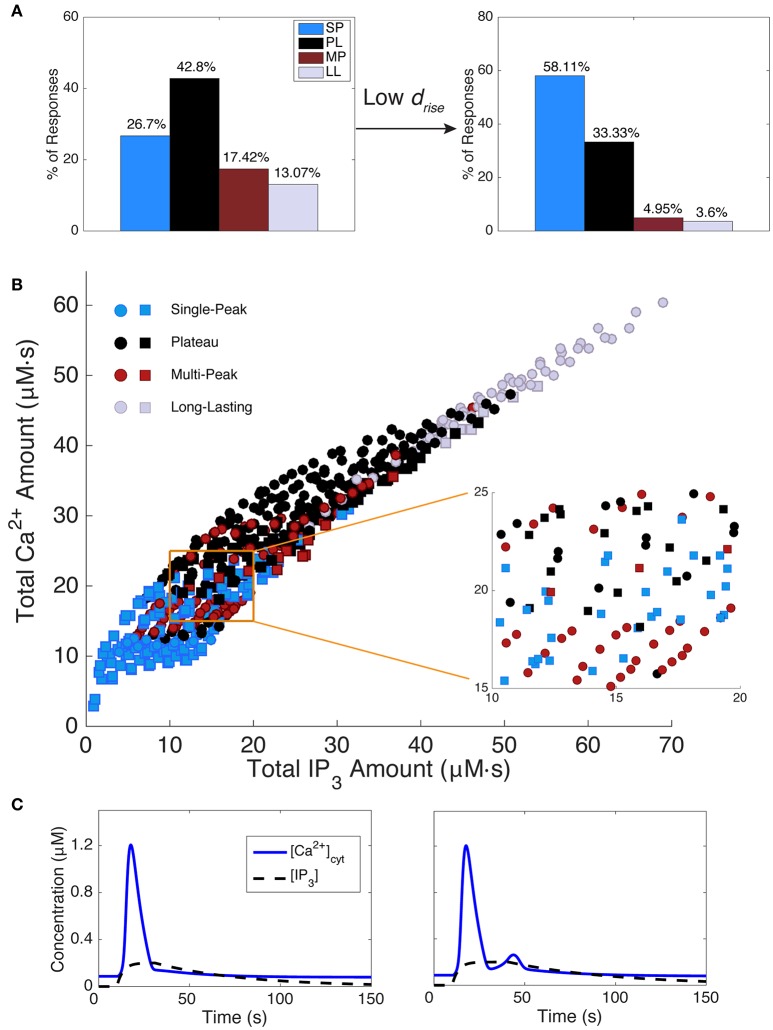
Effect of IP3 kinetics on Ca2+ responses. (A) The left histogram shows the distribution of model response types while scanning IP3 kinetics over the full parameter range from Table 1. The right histogram plots the response type distribution for shorter IP3 rise durations (drise < 22 s). Shorter IP3 rise durations tend to decrease the occurrence of mostly MP and LL responses, with SP being the major response type, while longer IP3 rise durations decrease the percentage of SP responses, but increase other response types. (B) The total IP3 amount correlates with the total Ca2+ amount. However, in most regimes, within a small range of IP3 (and Ca2+) amounts, a mixture of Ca2+ response types are generated. An example of such a regime is shown in the zoomed section. Squares indicate responses generated with drise < 22 s (corresponding to data set in the right histogram in (A) and circles indicate responses generated with all other drise values from Table 1. (C) Two example Ca2+ responses are shown with their underlying IP3 dynamics. As seen, a small change in IP3 kinetics is sufficient to change the Ca2+ response type from SP to MP, while the total IP3 amount remains roughly the same (15.28 and 15.17 μM, respectively; Ca2+ amounts are 13.86 and 15.56 μM, respectively). IP3 parameters (A, drise, rrise, ddec): 0.2, 21, 0.3, 220 (SP), 0.2, 31, 0.3, 179 (MP).